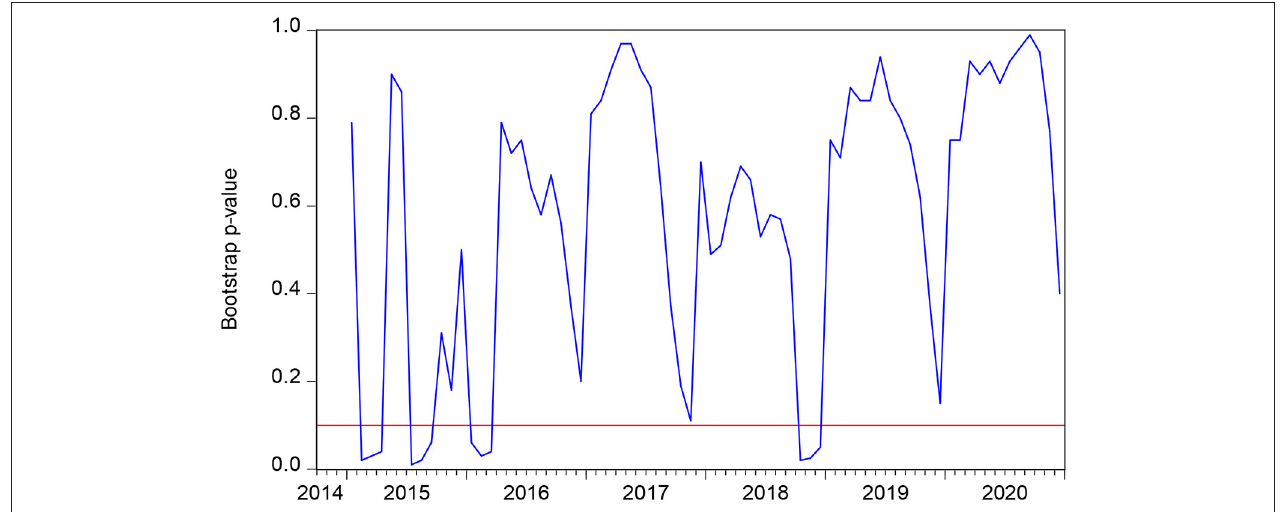
FIGURE 1 | The bootstrap p -value of the rolling test statistic testing the null that SMI does not Granger cause